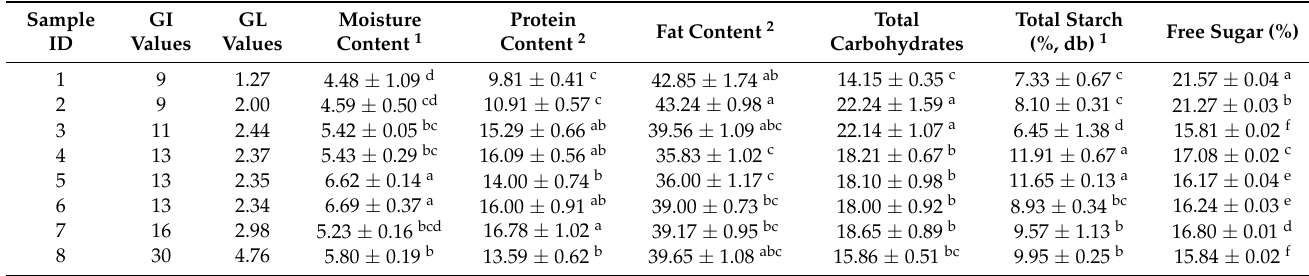
Table 3. Chemical compositions and the standard GI and GL values of